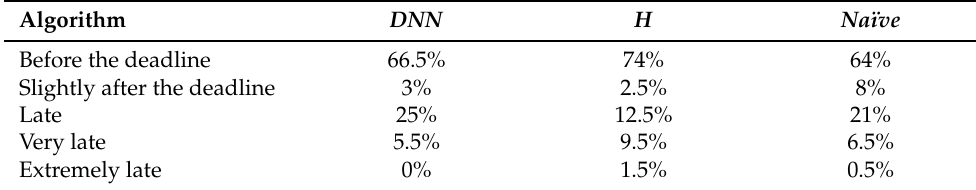
Table 5. Lateness distribution for the three policies for 10 readers and k =